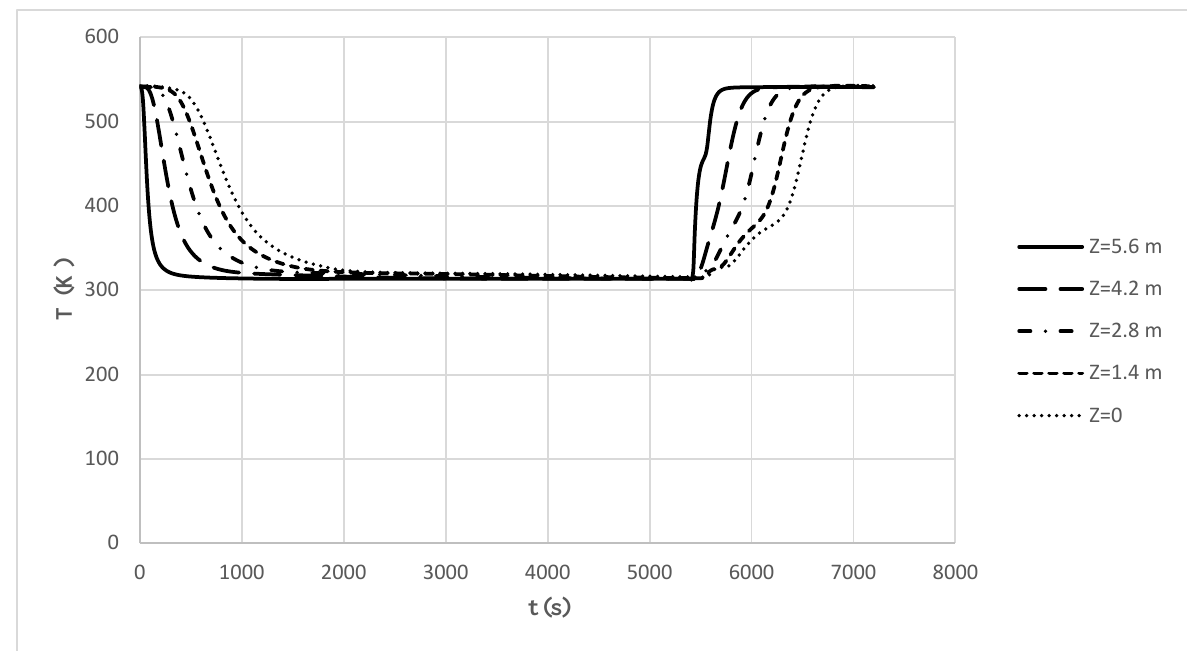
Figure 11. Temperature variation of the bed in the second layer with time.